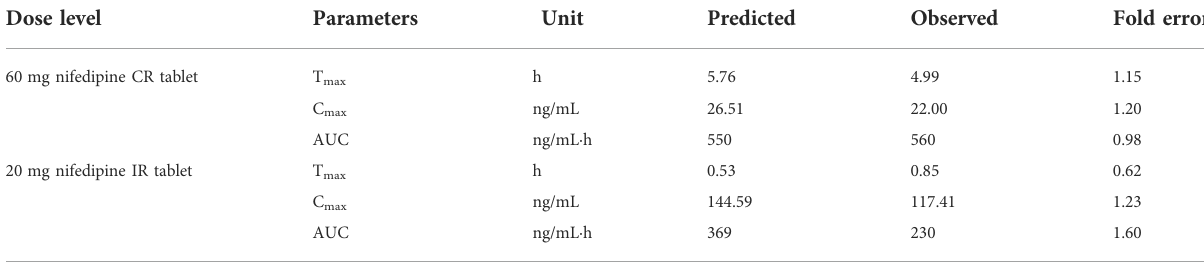
TABLE 3 Comparison of model-predicted C max , T max , and AUC to the observed data of nifedipine tablet.